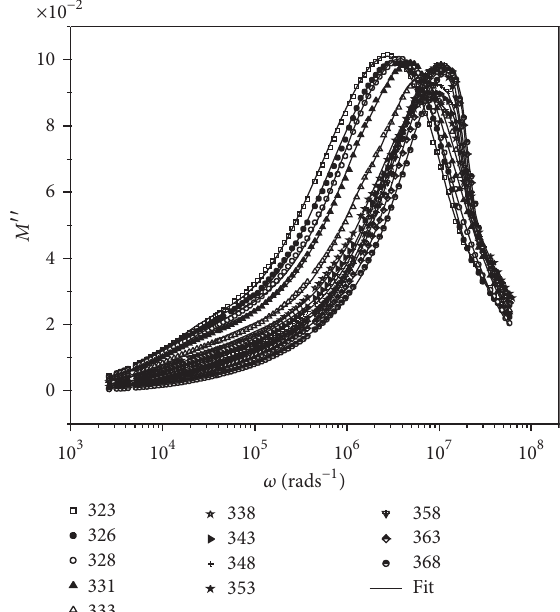
(cid:2497) (cid:9)(cid:83)(cid:66)(cid:69)(cid:84) (cid:230)(cid:18) (cid:10)